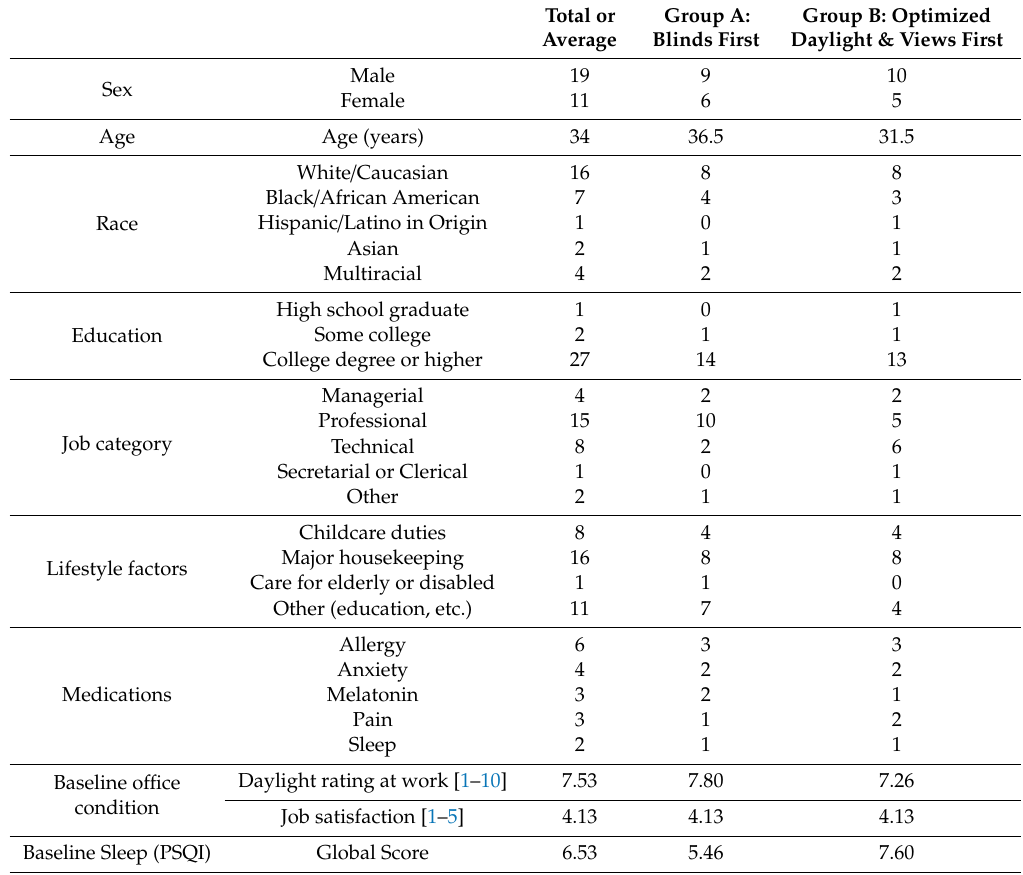
Table 1. Summary of Participant